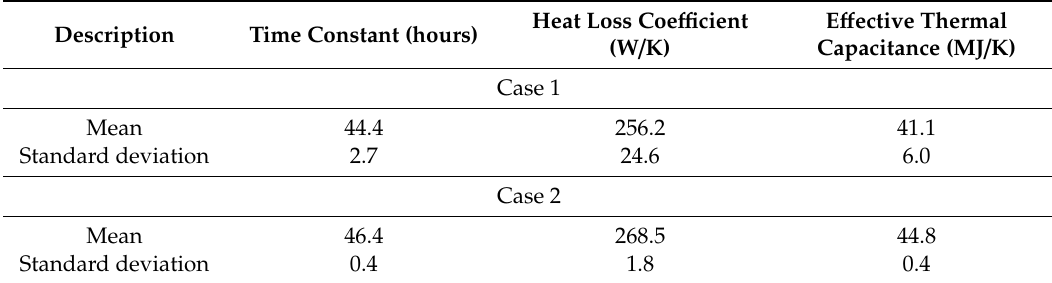
Table 4. Summary of results of dynamic heating Tests 1–3, 5, 6.